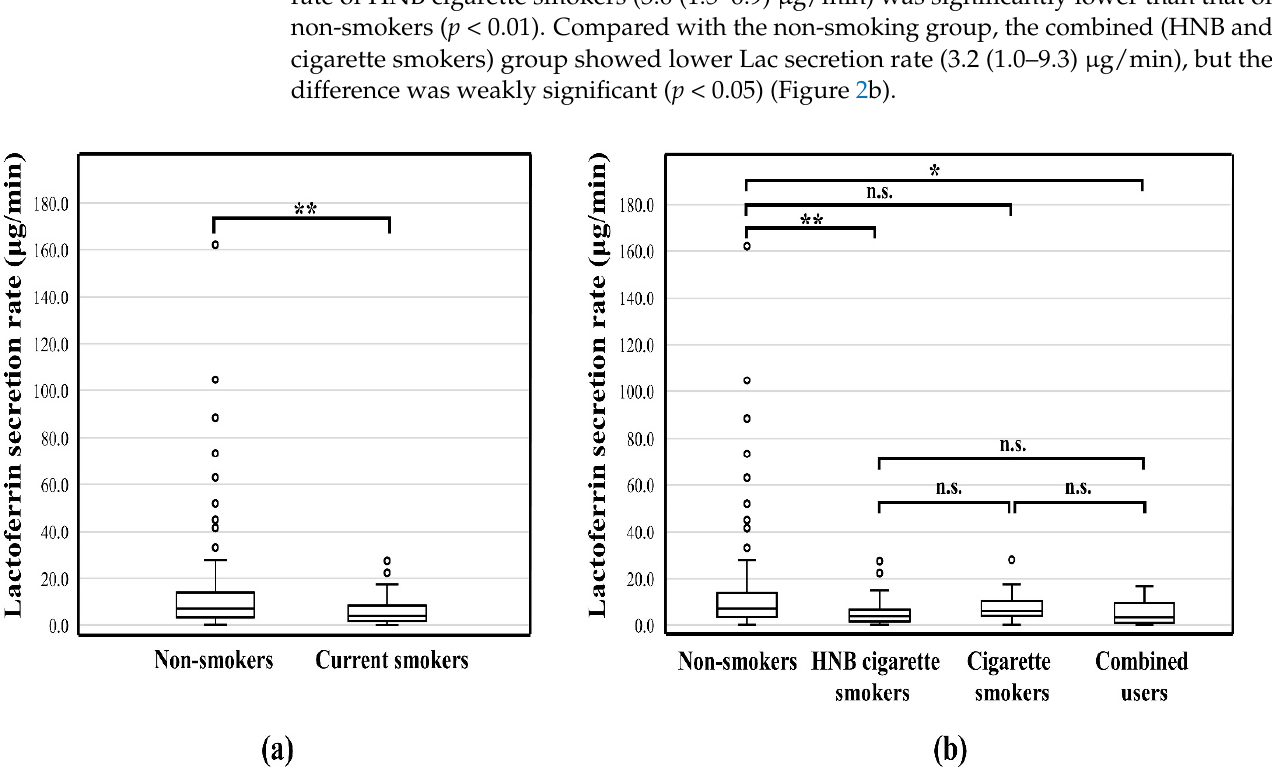
Figure 2. ( a ) Comparison of the rate of Lactoferrin secretion in non-smokers and smokers ; ( b ) Comparison of the rate of Lactoferrin secretion by different smoking devices; **, p < 0.01; *, p < 0.05; n.s., no significant difference; HNB, Heat-not-burn.